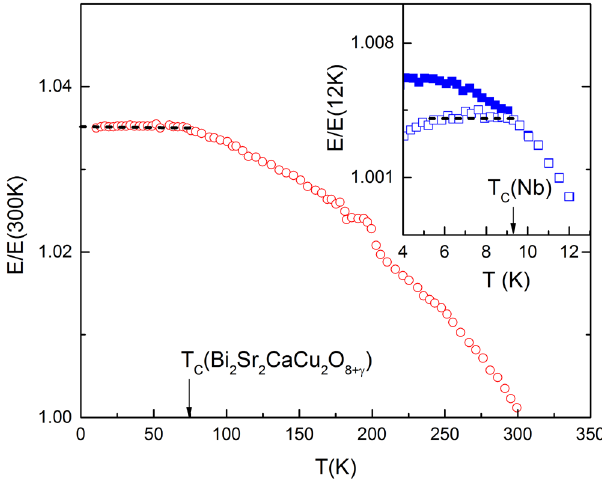
Figure 2. Elastic modulus of superconductors. Circles show E E K / (300 ) vs T of Bi 2 Sr 2 CaCu 2 O 8 +γ . The data are adapted from Lin et al . 32 . The predicted temperature invariance of the elastic modulus below ≈ T 8 K is C indicated by a horizontal dashed line. The inset shows E E K / (12 ) vs T of Nb in zero magnetic field (open squares) and in the presence of an applied magnetic field (solid squares) > H H which destroys the c 2 superconducting state. Inset data are adapted from Pal-Val et al . 34 . The predicted temperature independence of the elastic modulus below ≈ . T 9 3 K is indicated by a horizontal dashed C